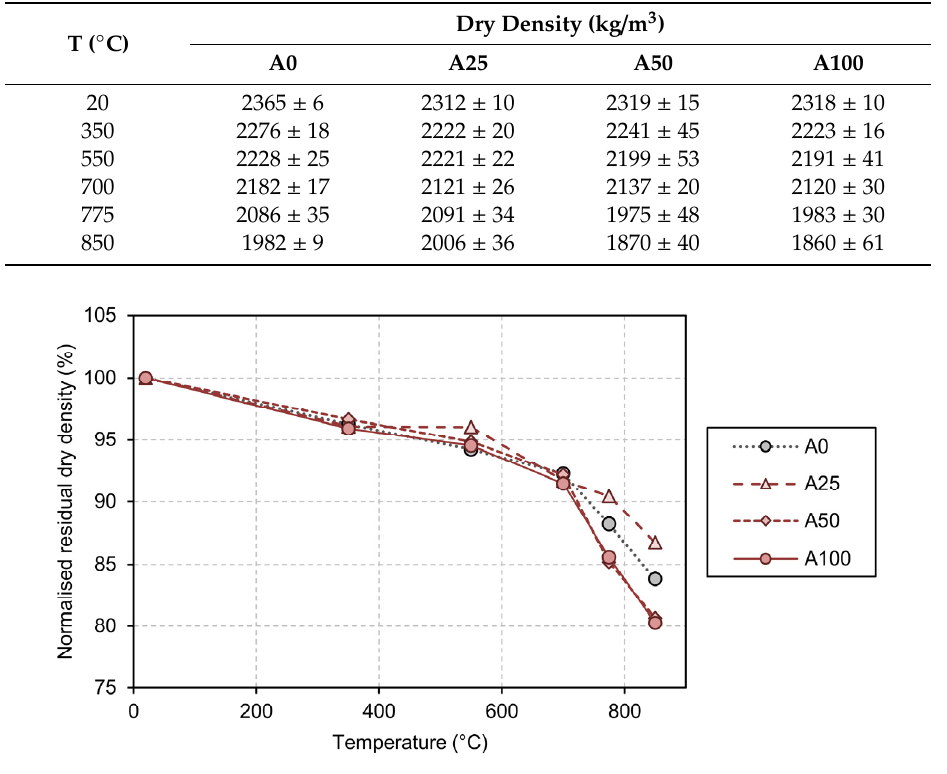
Figure 2. Evolution of density of natural aggregate concrete (NAC) and RAC with temperature.